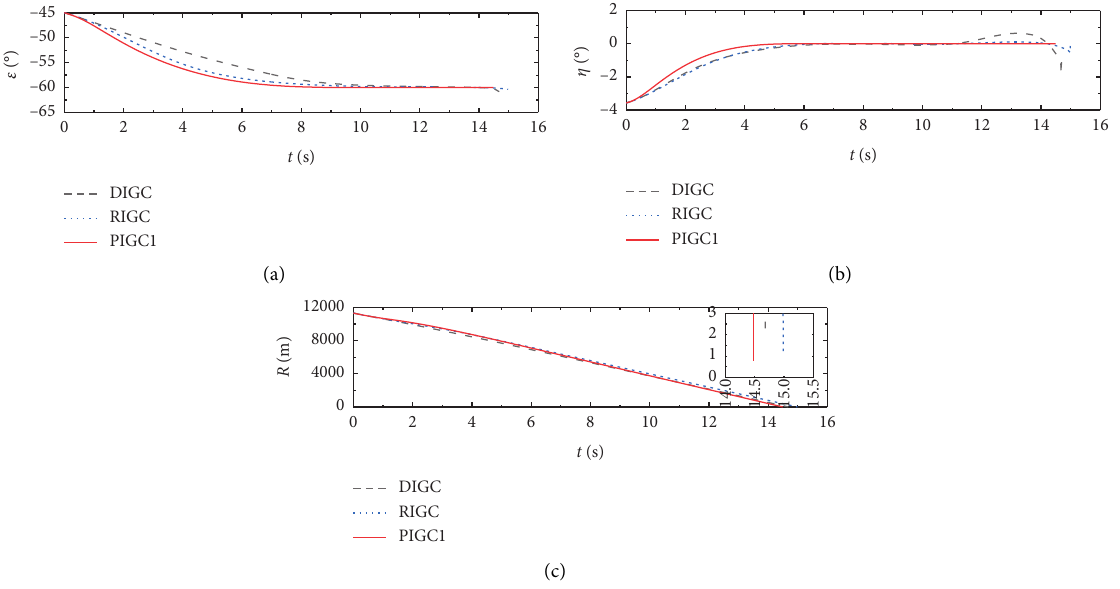
Figure 8: Curves representing LOS elevation and azimuth angles, distance between missile and target of Case 2.